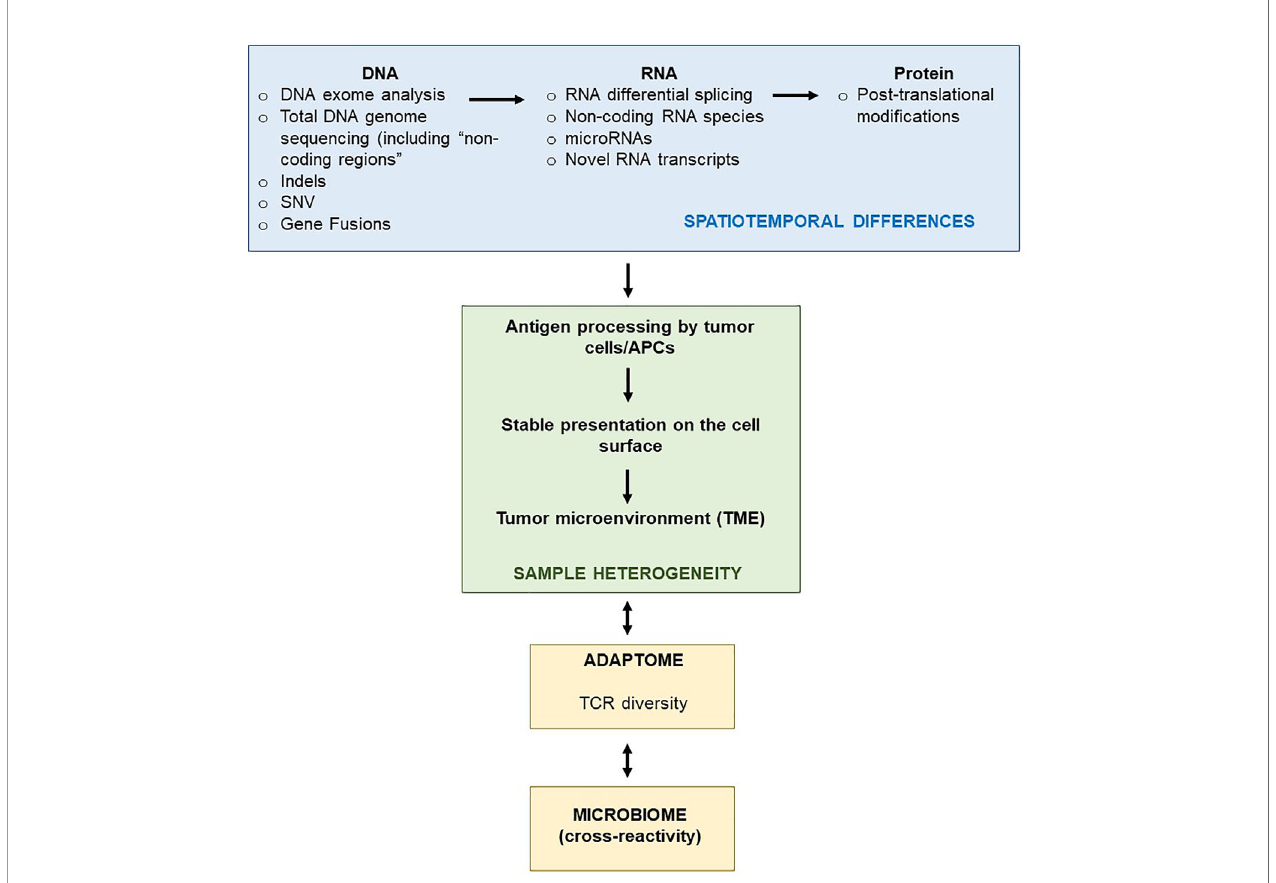
FIGURE 6 | Schematic representation of the general molecular paradigm of neoantigen recognition in the TME. The process of transcription of DNA to RNA and then to protein (antigens) is prone to generate heterogeneity in the context of cancer, i.e., the same DNA molecule may be differentially transcribed (due to RNA alternative splicing or mutations) and then translated to different proteins isotype (also as a result of post-translation modi fi cations) or there might be gene fusions that result in novel RNA transcripts. The heterogeneous expression of tumor antigens, as a result of spatial-temporal differences in DNA to antigen production, results in different antigens being presented to the immune system by HLA complexes (as well as whole antigens) at the cell surface of a tumor cell and, therefore, contributing to different sub-regional TMEs within the same tumor tissue sample. These are likely to be neoantigens, as they are not present in healthy (non-transformed) tissue. The TCR diversity ( “ adaptome ” ) will also change depending on the speci fi c TME, i.e., different TCRs will be encountered depending on intratumoral spatial differences. Along the same lines, molecular structures associated with the microbiome present in the tumor tissue may cross-react with some T-cells, depending on the presence of absence of TCRs that recognize such microorganisms. The possible cross-reactivity, if present, may favor the expansion of the relevant immune-cell populations and, therefore, change the TCR